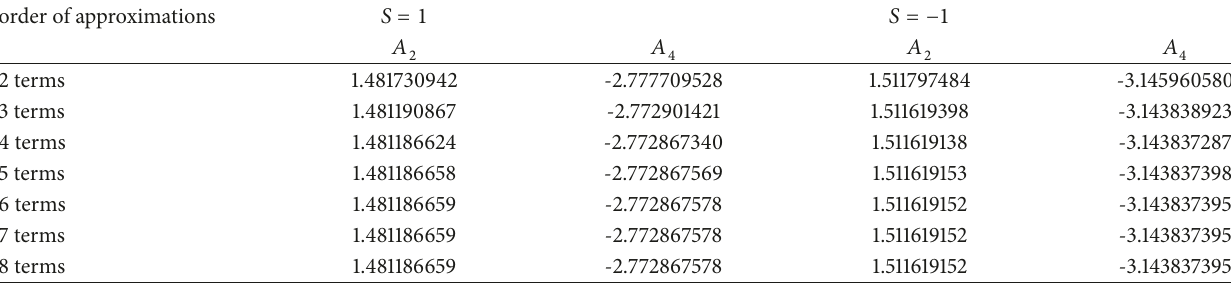
Table 4: Comparison of the values for skin friction coefficient (1 + 1/𝛾)𝑓 󸀠󸀠 (1) .